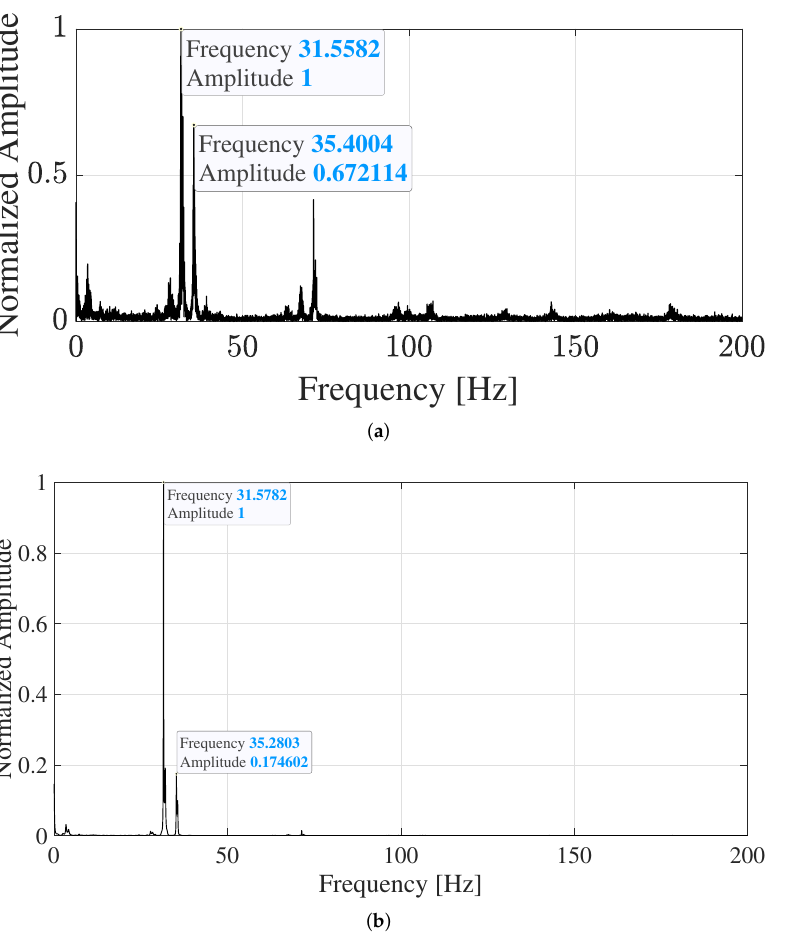
Figure 11. Example of vibration frequency computed with ( a ) FFT and ( b ) MUSIC with a subspace dimension equal to 512. Both spectra are normalized in amplitude to be easily